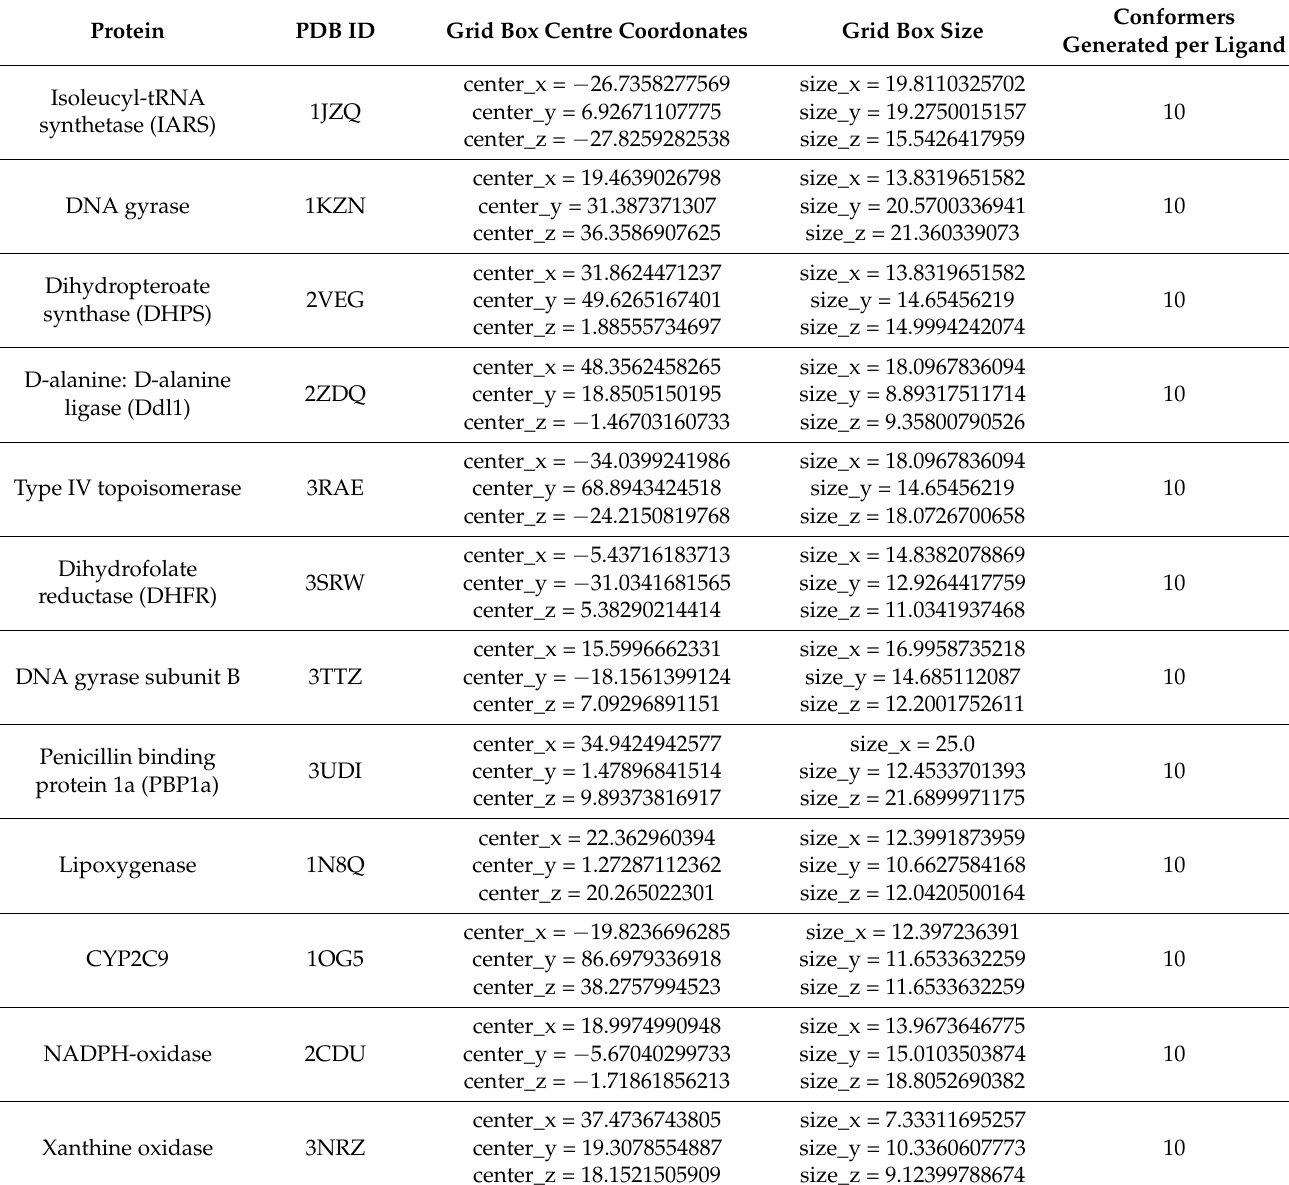
Table 1. Molecular docking parameters and protein